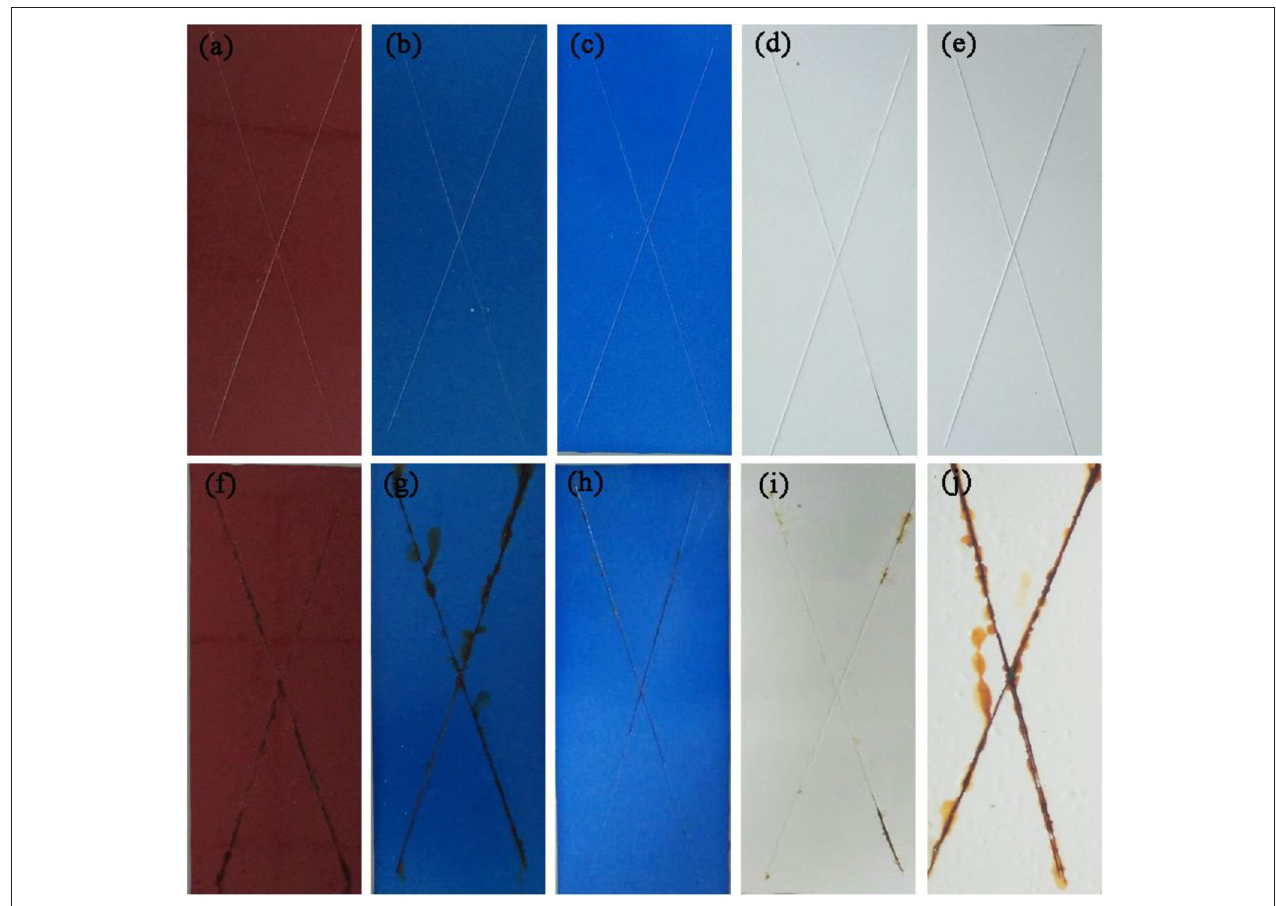
FIGURE 7 | Photographs of the film containing (a) Fe 2 O 3 , (b) CoAl 2 O 4 , (c) CoAl 2 O 4 /Kaol hybrid pigment, (d) Kaol, and (e) ZnO. (f–j) The corresponding images of the film after being exposed to acetic acid-salt spray for 60 days, respectively.